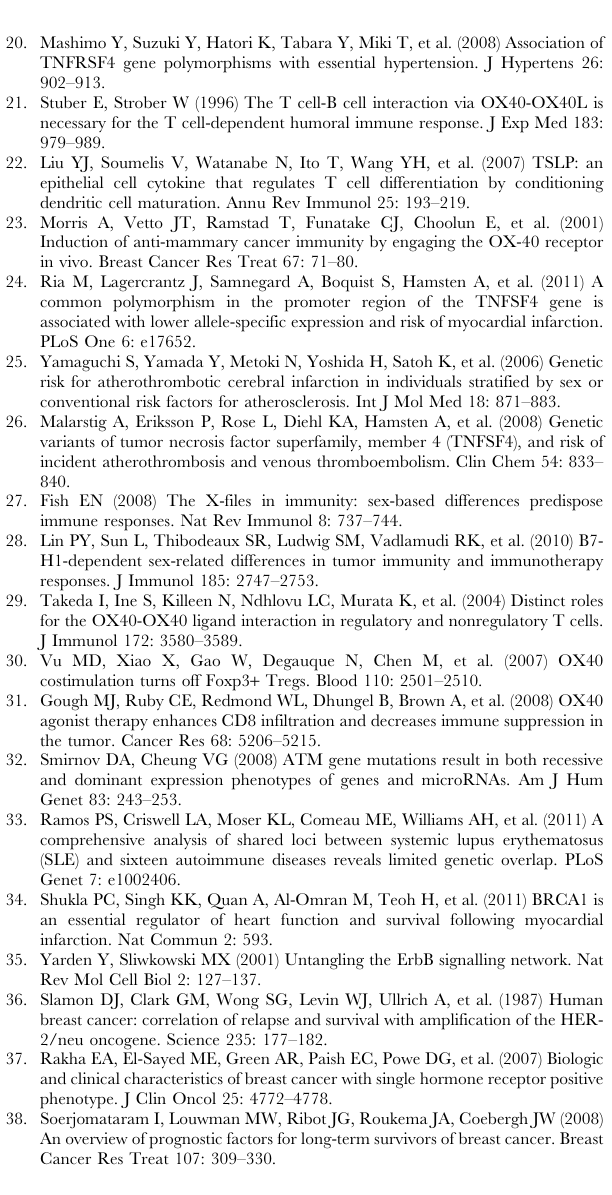
Table S2 Associations between haplotype of OX40L gene SNPs and C-erbB2 status in cases. Blocks were constructed as the method of solid spine of LD according to the values of D’ generating from our own data. Haplotype data was analyzed